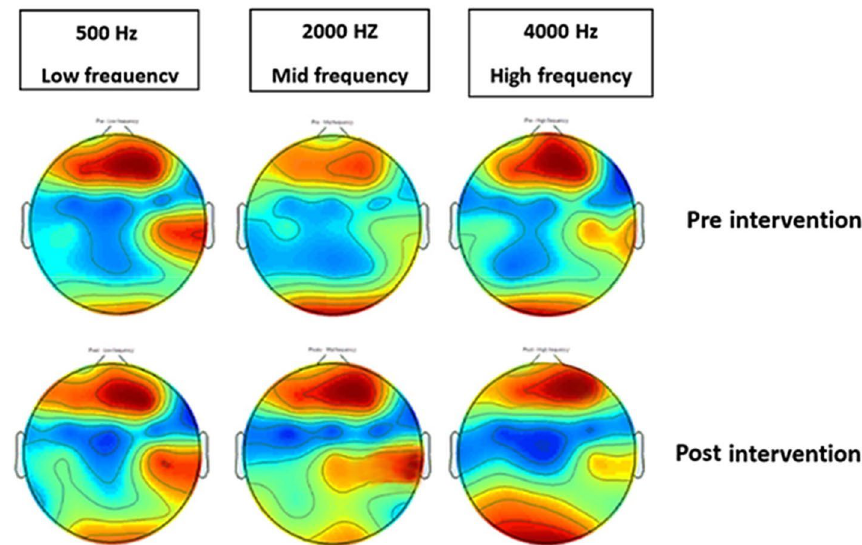
Fig. 4 The graphic map of ASSR 40-Hz amplitude changes after tinnitus management with binaural beat stimuli at three carrier